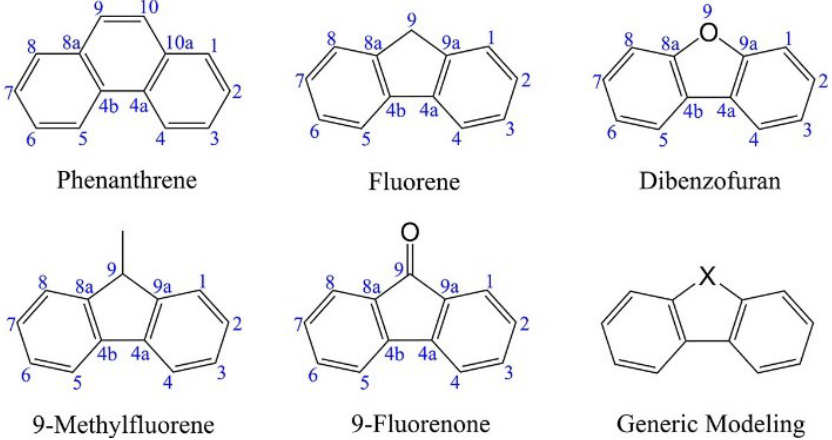
Scheme 1. Illustrative structural diagrams for phenanthrene, fluorene,